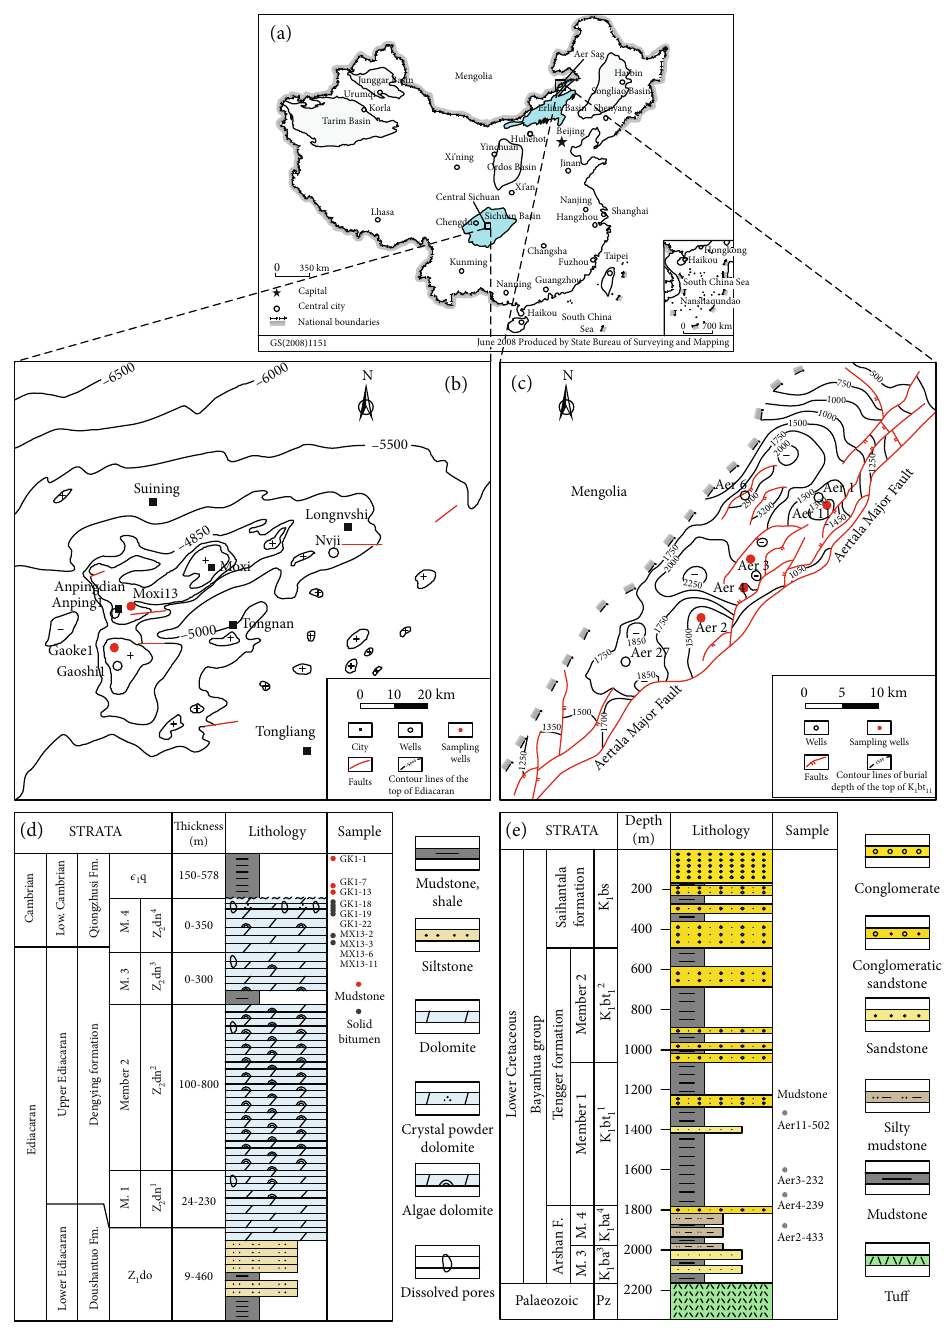
Figure 1: Generalized structural location map and stratigraphic column for the Central Sichuan Basin and Aer Sag in Erlian Basin. (a) The distribution of sedimentary basins in China. The structural location map of (b) the Central Sichuan Basin and (c) the Aer Sag modi fi ed after [36, 37], respectively. The stratigraphic column of (d) the Central Sichuan Basin and (e) the Aer Sag modi fi ed after [36, 42],